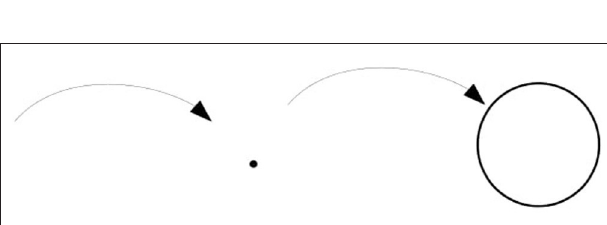
FIGURE 9 | Dynamics around a stable limit cycle (top left), an unstable limit cycle (bottom left) and a folded limit cycle (right) of Equation (26).